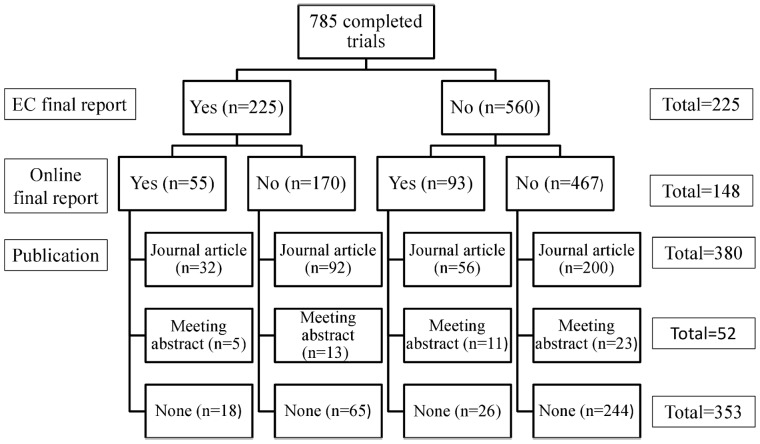
Flowchart of study results research.